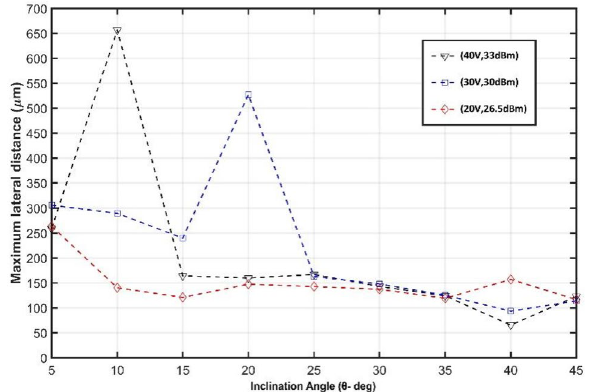
Figure 7. Optimization results of Inclination angle ( θ ) to achieve the maximum feasible separation efficiency for PS particles of 4 μm and 10 μm diameter.